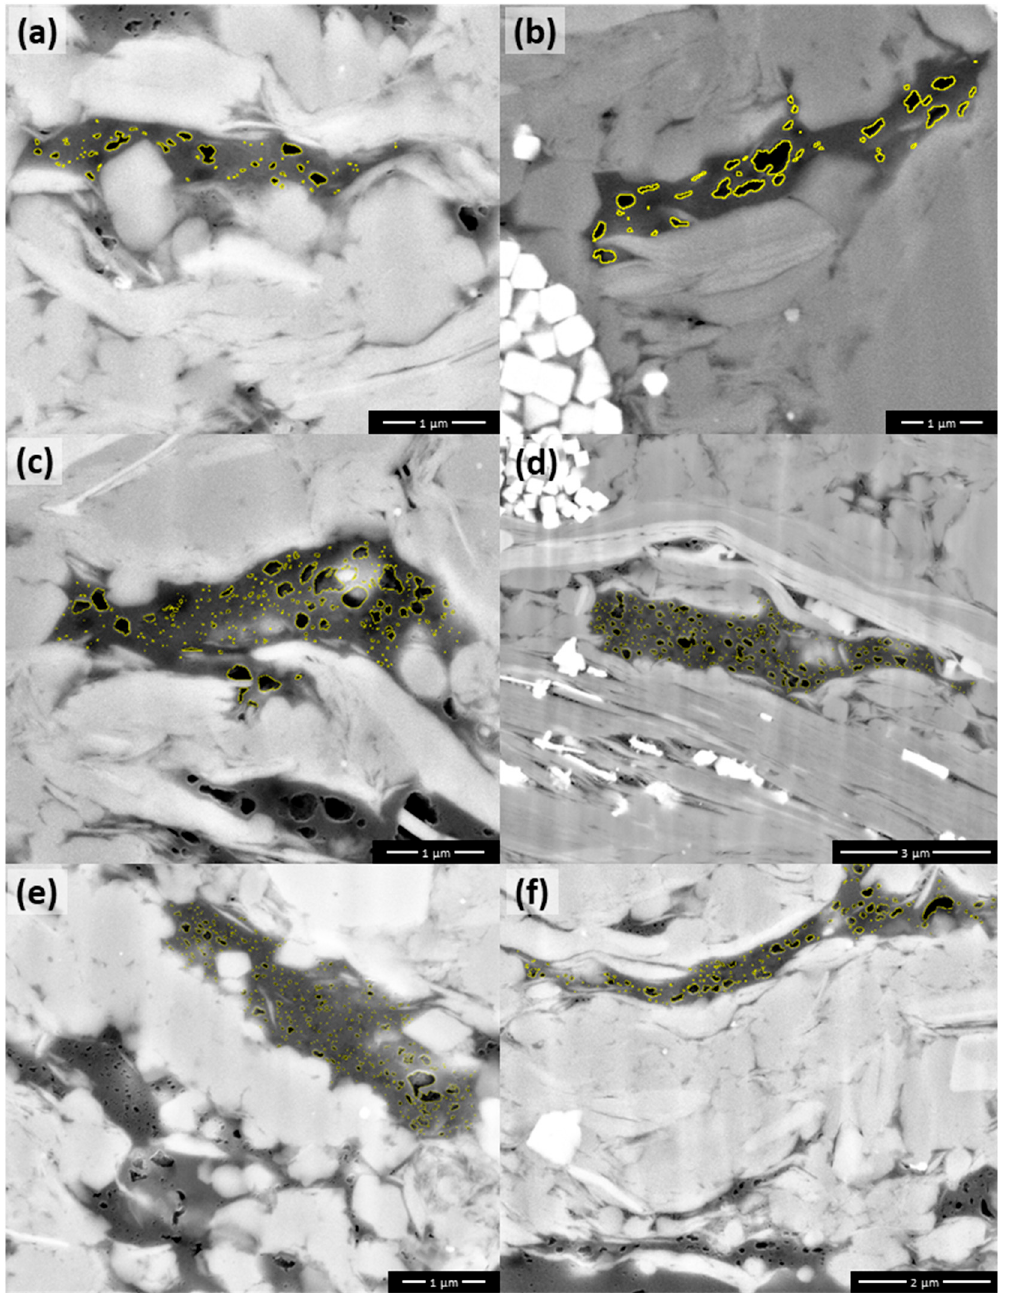
Figure 6. The typical examples of the second subtype of weakly or undeformed porous pyrobitumen (OM II) from Longmaxi-Wufeng Shale, Sichuan Basin. ( a ) SEM image JY1S-9-12 (well ID-sample no.-image no.); ( b ) SEM image JY1S-9-18; ( c ) SEM image JY1S-9-35; ( d ) SEM image JY1S-15-08; ( e ) SEM image JY8S-3-34; and ( f ) SEM image JY1S-14-10. The boundary of OM-hosted pores is outlined in yellow.